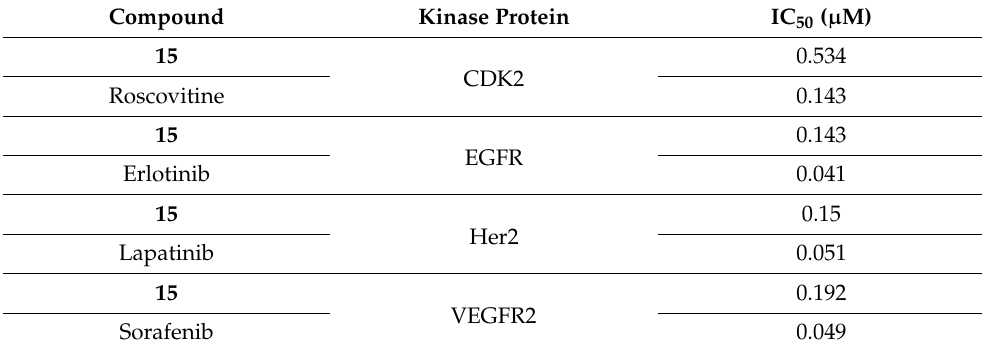
Table 2. Kinase inhibitory effects of compound 15 on EGFR, Her2, VEGFR2 and